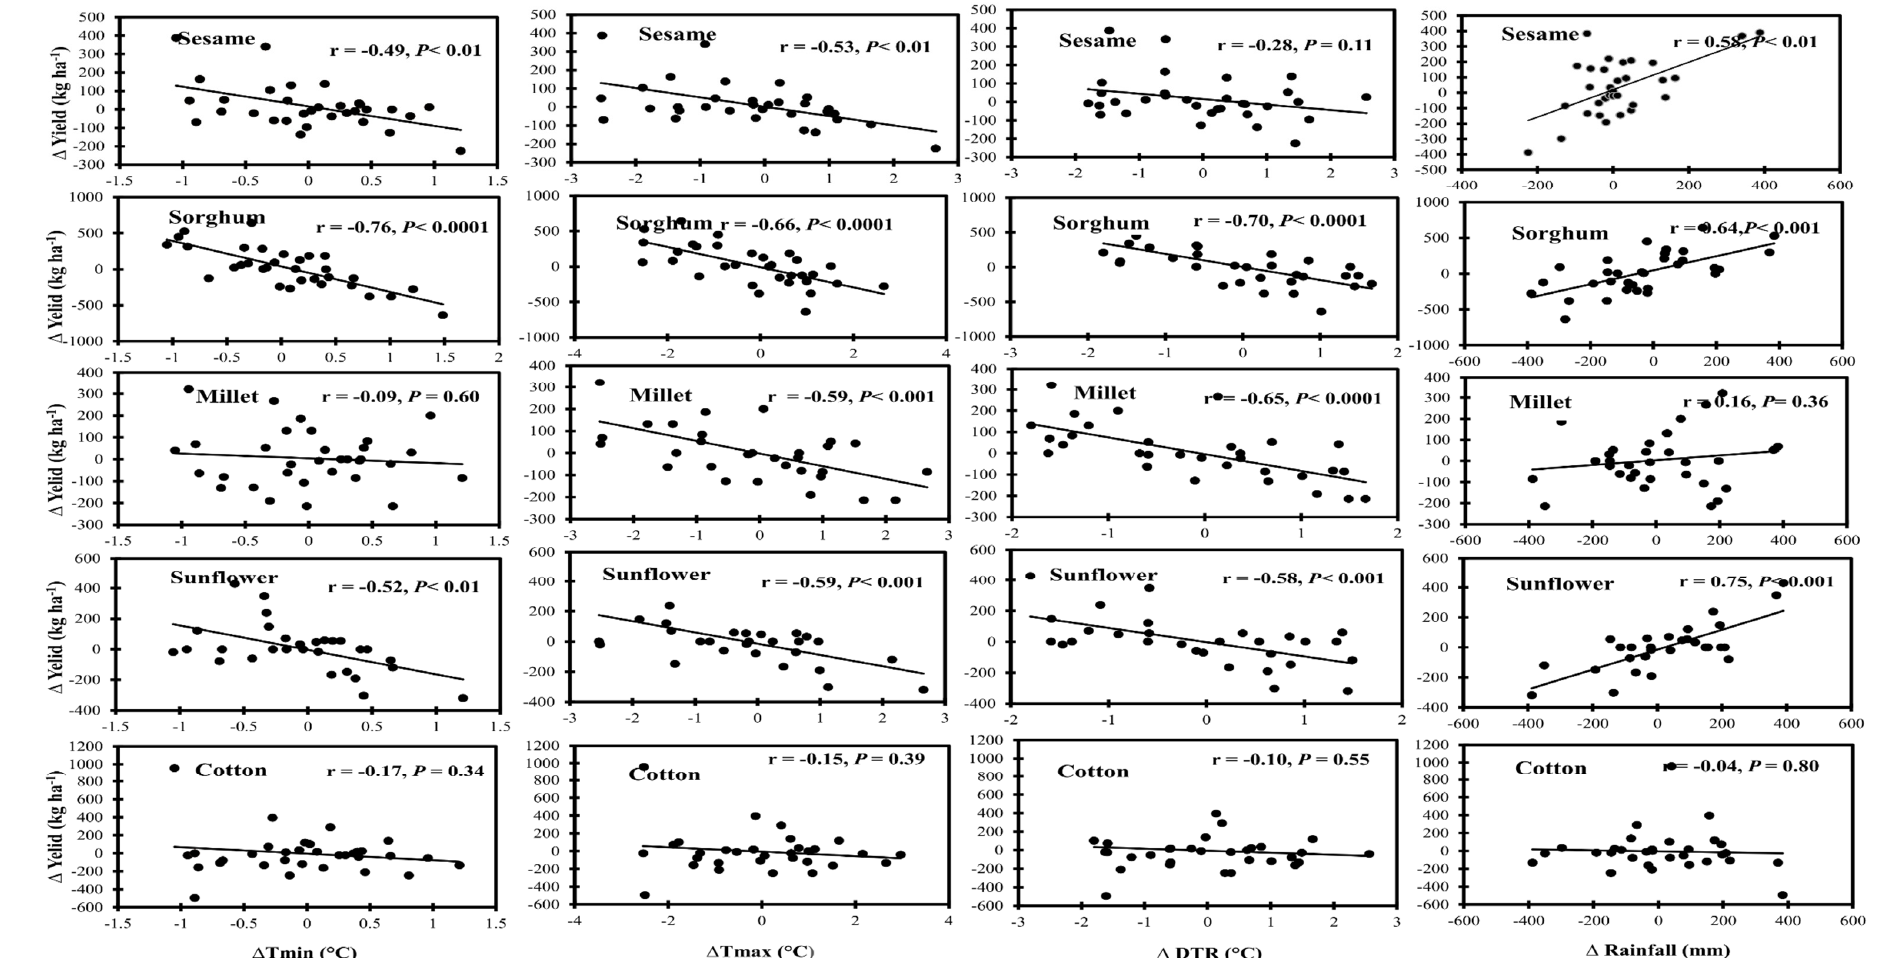
Figure 8. Associations, as assessed by a Pearson’s correlation analysis, among climatic variables and yield of five major crops grown in Gedaref State, Sudan. r is correlation coefficient.